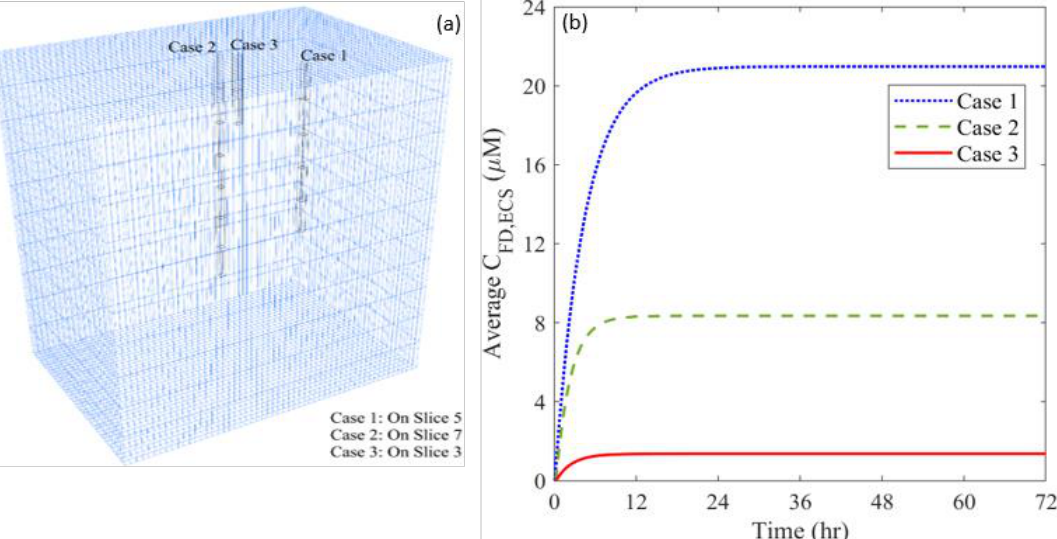
Figure A8. ( a ) Location of different infusion sites of cell volume fraction, and ( b ) its impact on the time course of free temozolomide concentration in the brain tumor.